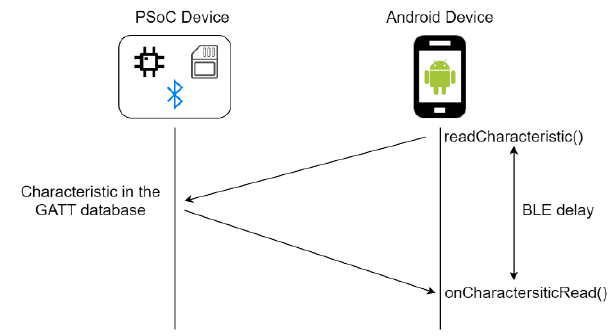
Figure 13. Test scenario to measure the BLE delay.